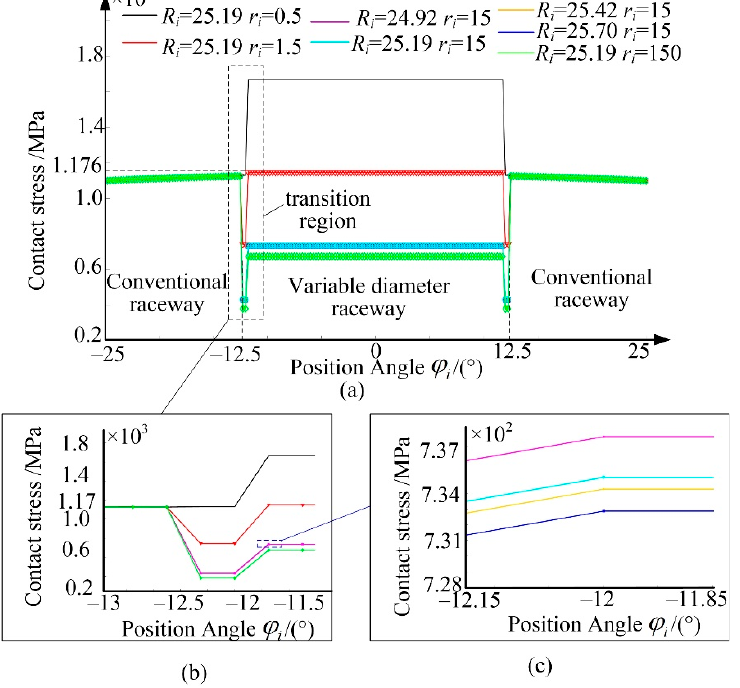
Figure 3. Relationship between contact stress and position angle for different curvature radii: ( a ) The complete process of rolling elements movement, ( b ) transition region of variable diameter raceway, ( c ) The junction of the variable diameter raceway and the transition region.